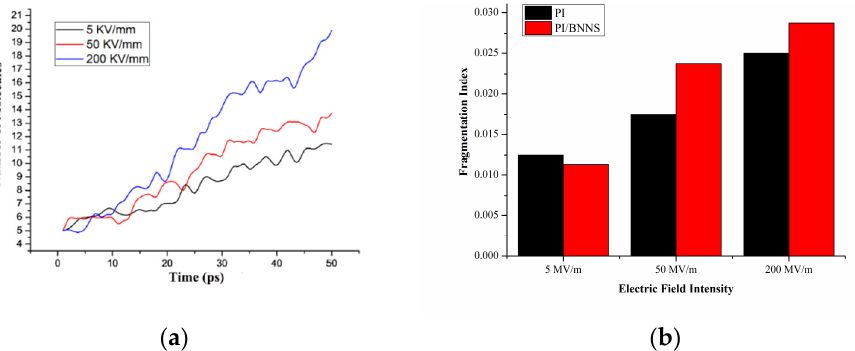
Figure 10. The decomposition degree of different systems under different electric field intensities. ( a ) Molecular number of the PI neat system at different electric field intensities; ( b ) Fragmentation index at 50 ps of the PI neat and PI/BNNS systems at different electric field intensities.